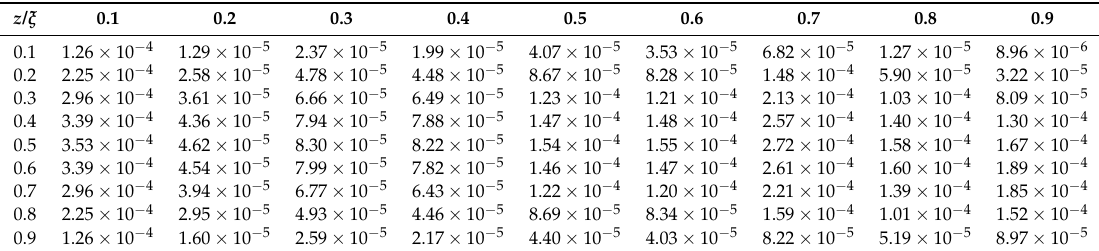
Table 3. Absolute error values of Example 1 for Burgers’ equation with α = 0.8.